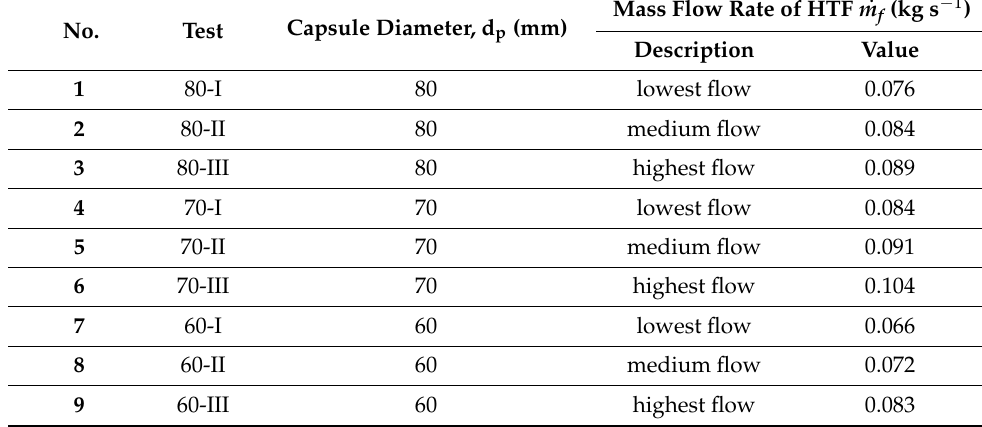
Table 2. Description of the experimental tests. No.